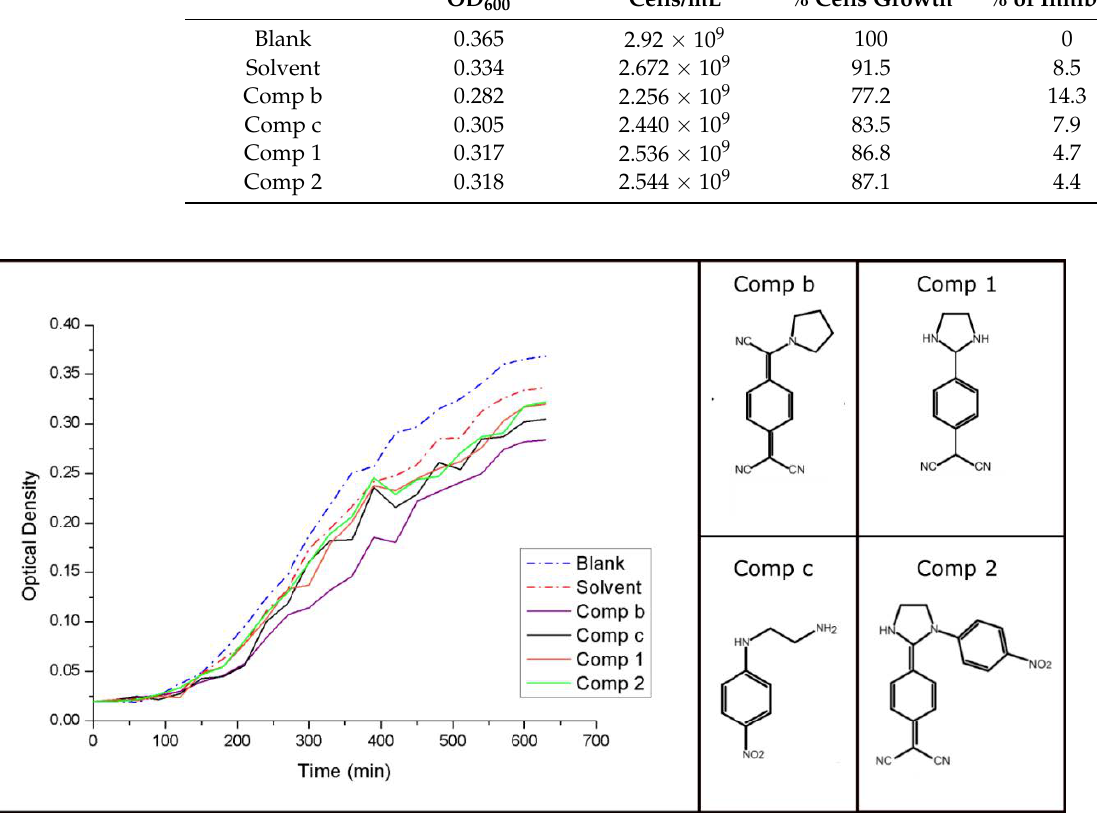
Table 3. Final OD 600 values, the estimated number of cells per ml, and percentages of inhibition for each growth curve.